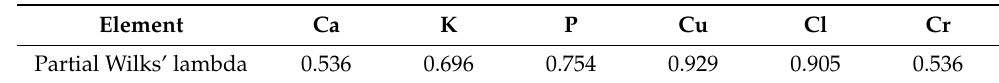
Table 1. Partial Wilks’ lambda value.